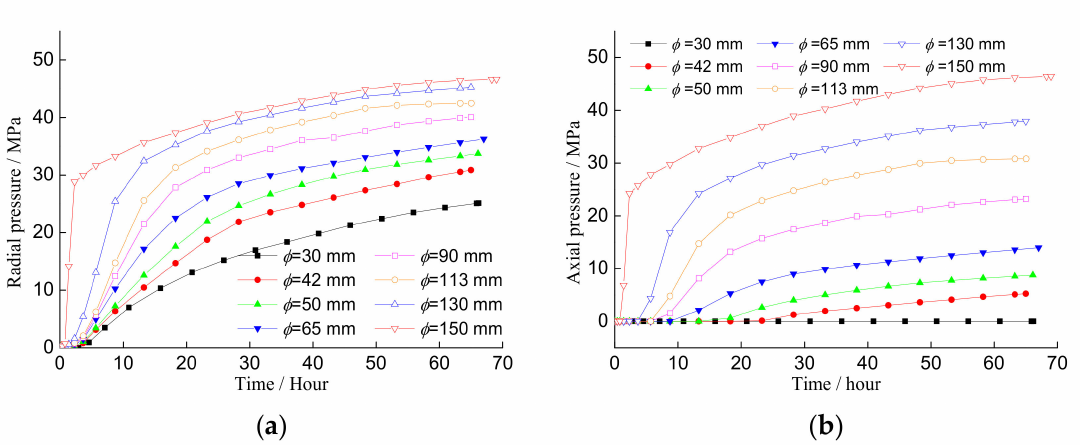
Figure 5. Time histories of radial and axial expansive pressures obtained by numerical simulation: ( a ) radial expansive pressure, ( b ) axial expansive